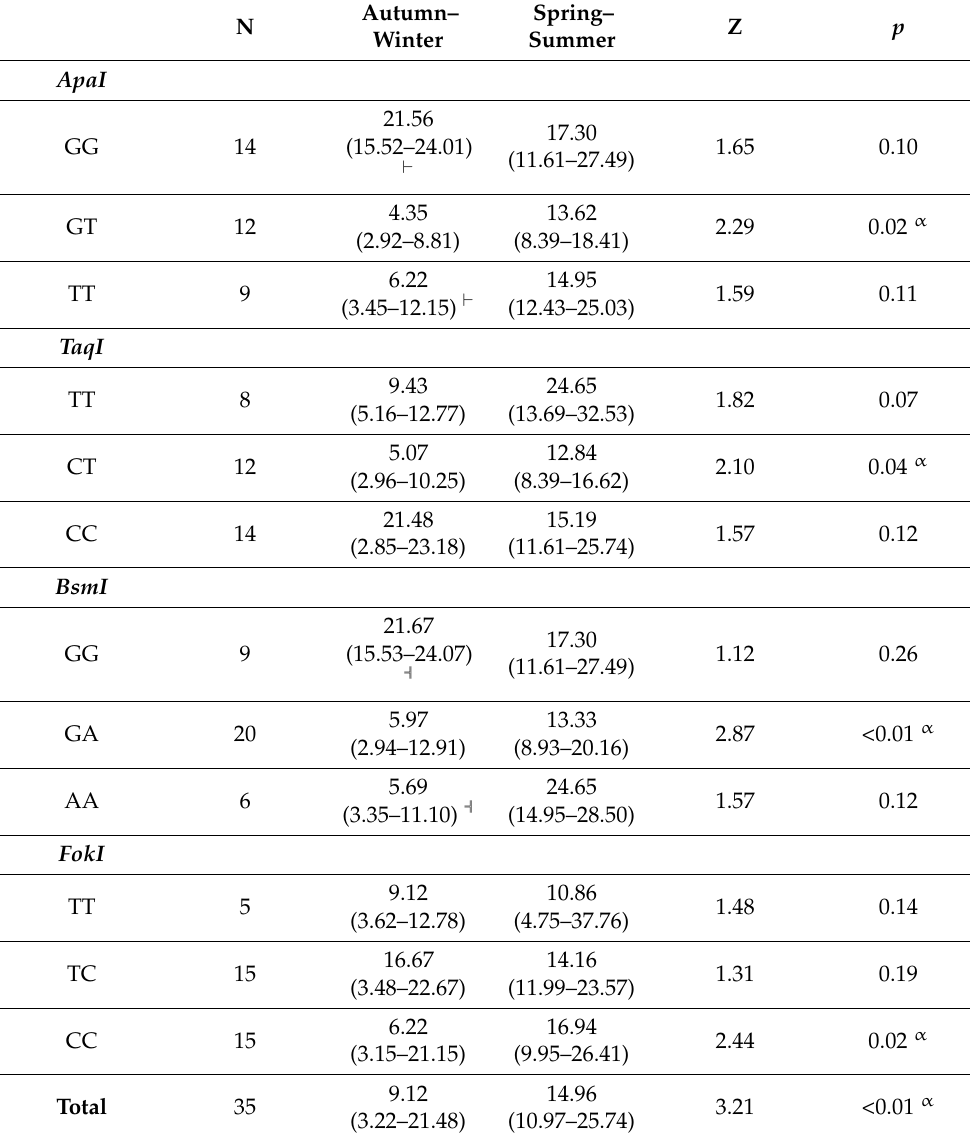
Table 8. Inter-seasonal changes of 25(OH)D3 in patients’ plasma according to the VDR polymorphism.